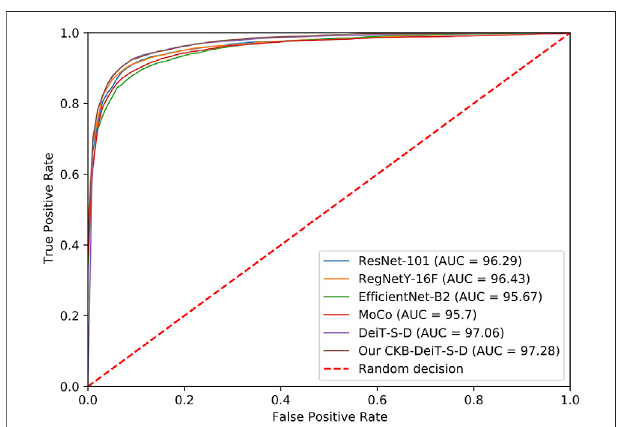
FIGURE 5 | ROC curves of different methods for the DFU infection classi fi cation.